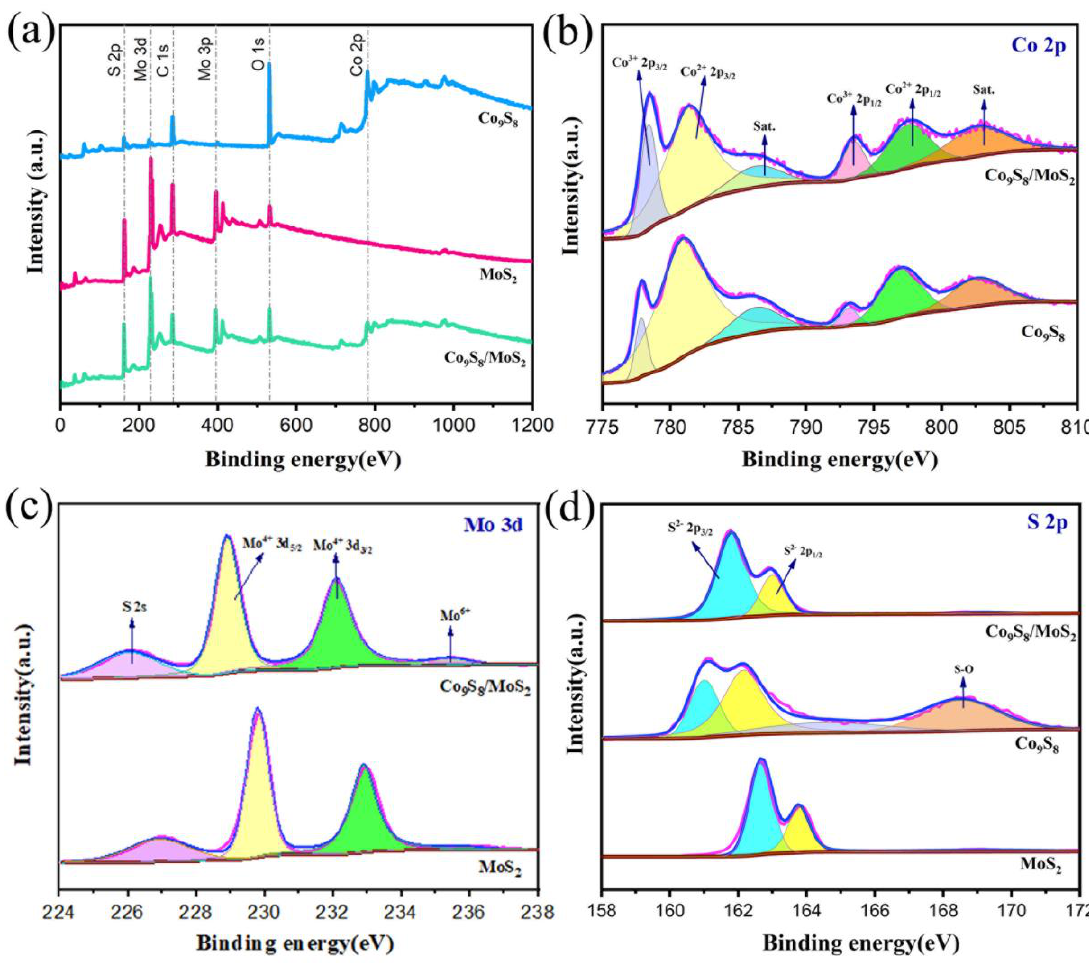
Figure 6. ( a ) XPS survey spectra of Co 9 S 8 , MoS 2 , and Co 9 S 8 /MoS 2 ; ( b ) high-resolution Co 2p XPS spectra of Co 9 S 8 and Co 9 S 8 /MoS 2 ; ( c ) high-resolution Mo 3d XPS spectra of MoS 2 and Co 9 S 8 /MoS 2 ; ( d ) high-resolution S 2p XPS spectra of Co 9 S 8 , MoS 2 , and Co 9 S 8 /MoS 2 .